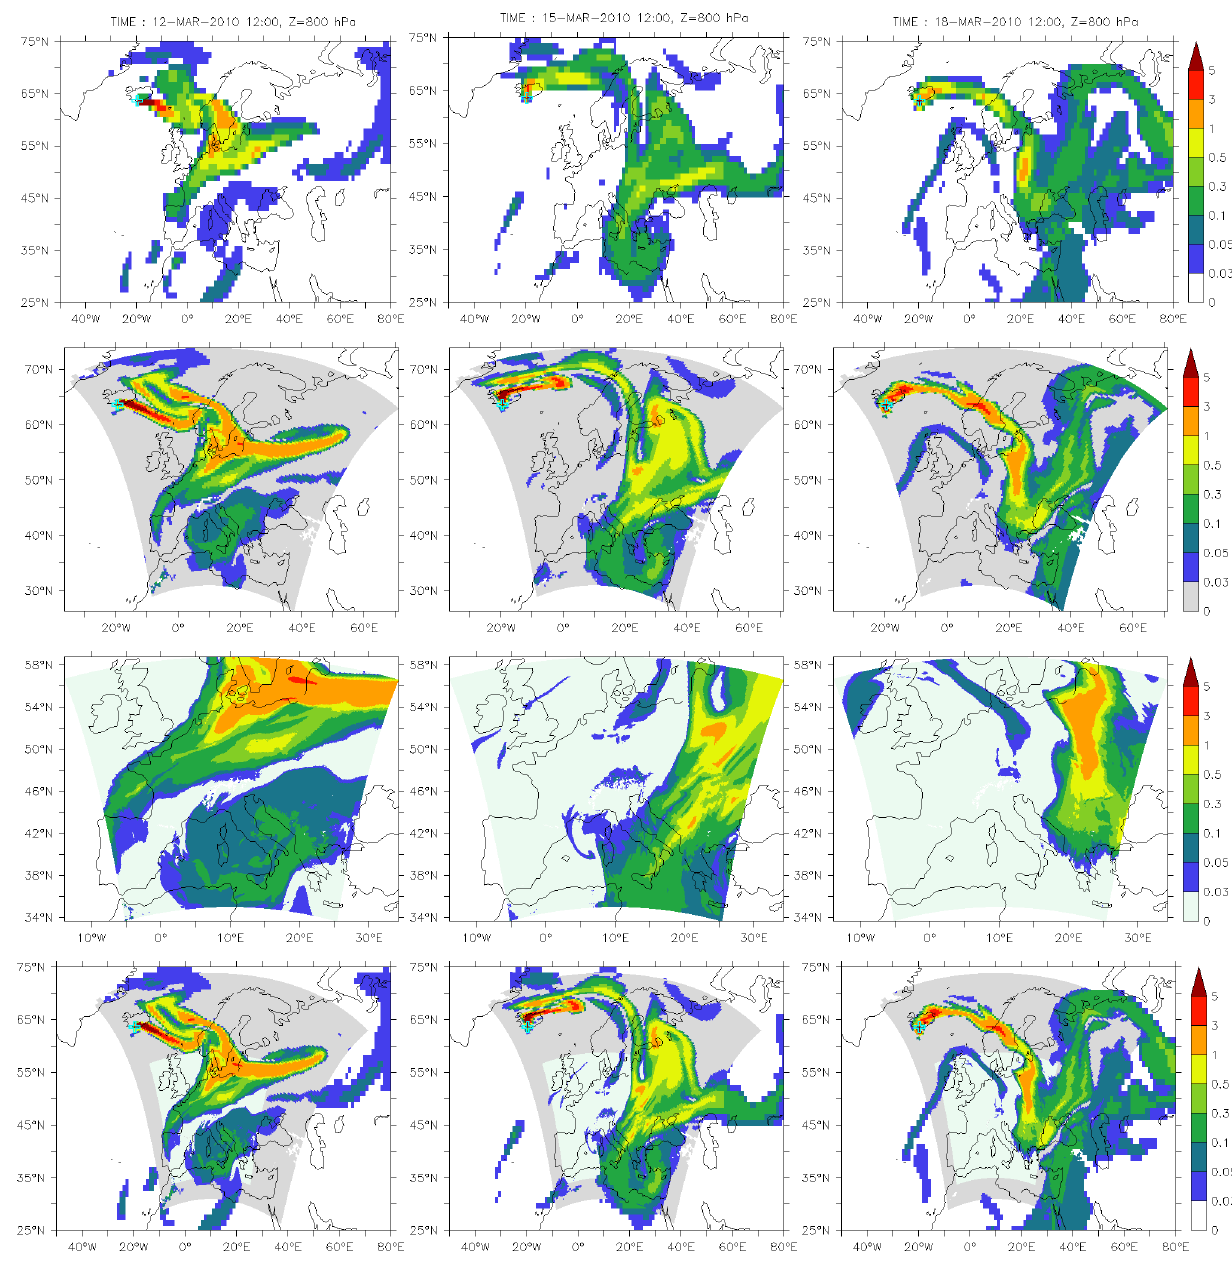
Fig. 8. Horizontal distribution at 800 hPa of the artificial tracer VOL. The location of the emission point is indicated by the light blue plus sign. Results are shown for the 12th, 15th and 18th simulation day at 12:00 UTC (columns). First row: ECHAM5/MESSy, second row COSMO-40/MESSy, third row COSMO-7/MESSy and last row composite of all three model domains.